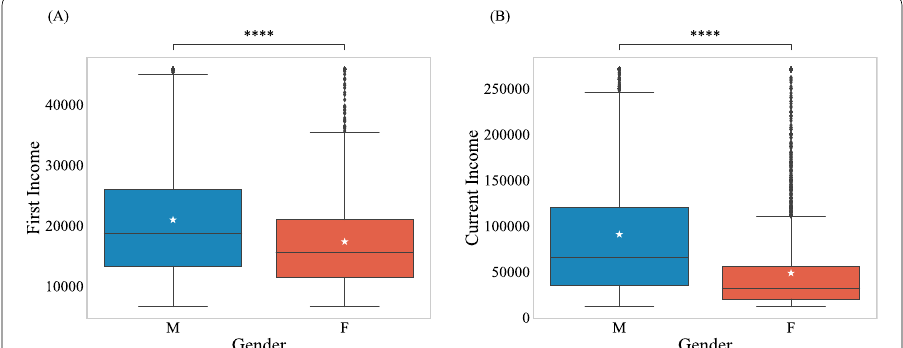
Fig. 5 First Income and Current Income boxplot based on Gender (male M, and female F) distribution count